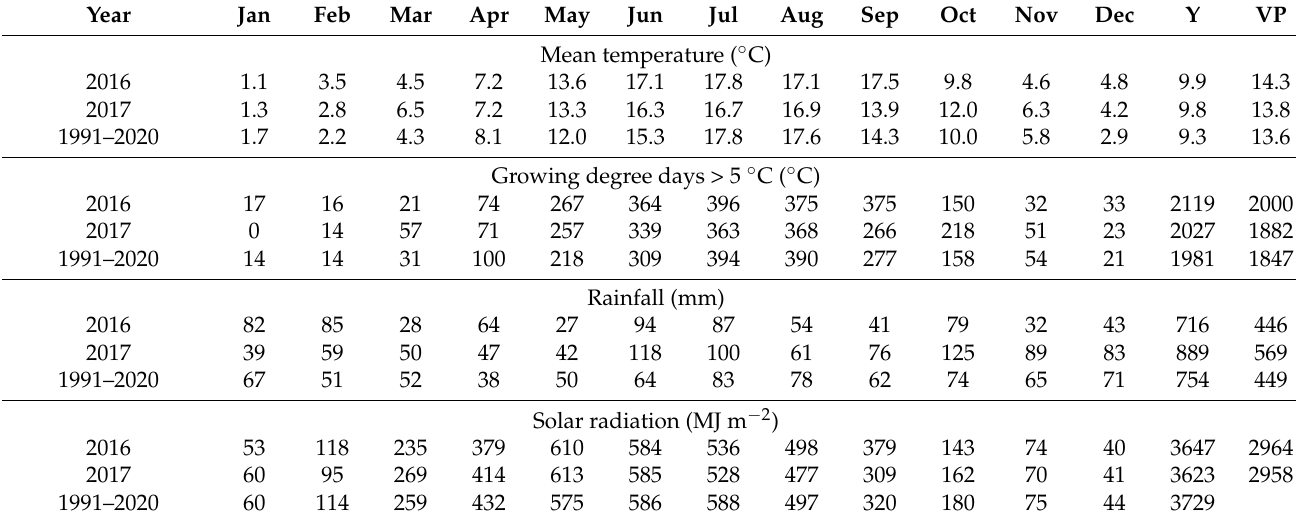
Table 1. Mean temperature ( ◦ C), growing degree days above 5 ◦ C (GDD; ◦ C), total rainfall (mm), total solar radiation (MJ m − 2 ) per month, year (Y) and vegetation period (VP; April to October) of 2016, 2017 and the long-term average